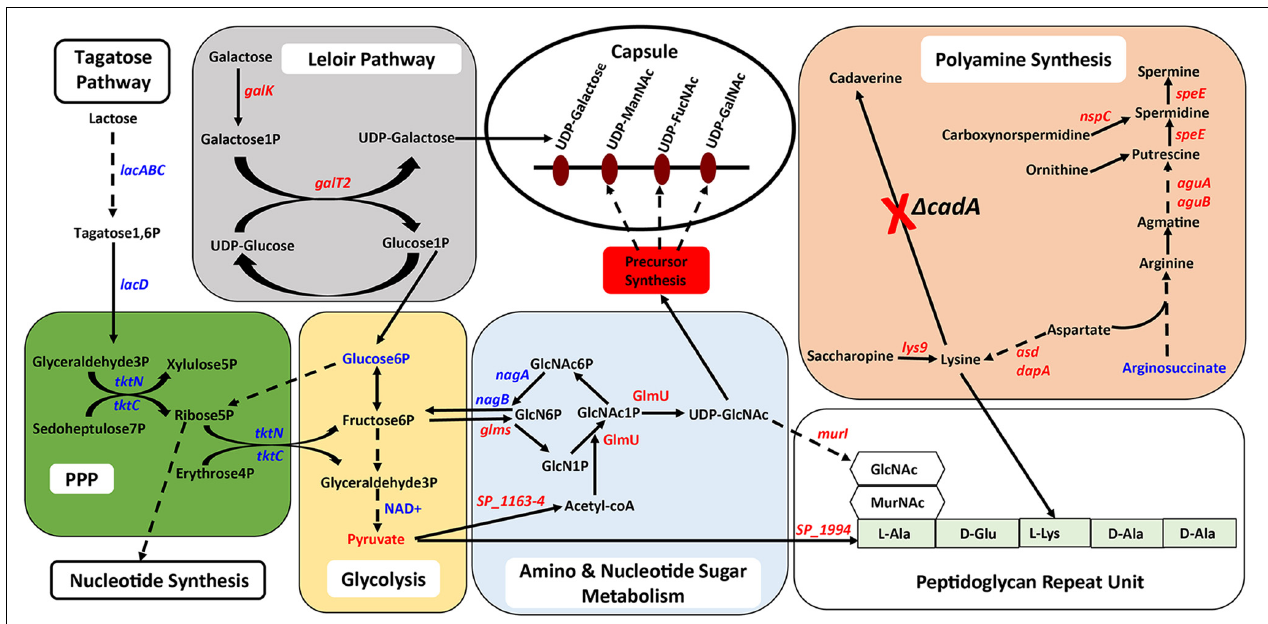
FIGURE 5 | Intersection between polyamine biosynthesis, carbohydrate metabolism, and the capsule in pneumococci. Interconnected metabolic pathways in a putative lysine decarboxylase synthesis deficient strain of S. pneumoniae TIGR4 ( (cid:49) cadA ) analyzed by RNA-Seq and metabolomics identified specific molecular mechanisms that could result in reduced intracellular levels of the constituents of the serotype four capsule and PG repeat structures. Enzymatic reactions are shown as black arrows and multi-step reactions are represented by a broken arrow. Changes in gene (italicized) and metabolite levels in (cid:49) cadA relative to the wild-type strain are shown (red represents decrease and blue represents increase). Deletion of cadA results in reduced expression of genes encoding biosynthesis pathways of polyamines such as putrescine, spermidine, and spermine and precursor amino acid lysine. Accumulation of arginosuccinate, an intermediate for the biosynthesis of arginine supports the notion of overall reduction in polyamine synthesis in (cid:49) cadA. Impaired polyamine synthesis renders pneumococci incapable of UDP-Glu to UDP-Gal interconversion, i.e., Leloir pathway (gray square), that could reduce the carbon flux through glycolysis (yellow rectangle). Despite increased carbon flux toward G3P, a glycolytic intermediate, through tagatose metabolism, changes in the levels of metabolites of glycolysis indicate reduced carbon flux. RNA-Seq data indicated that G3P is routed through the PPP (green square), and enhanced PPP activity will result in increased nucleotide synthesis. Changes in amino and nucleotide sugar metabolism (blue square) will result in reduced intracellular levels of UDP-GlcNAc, a precursor for three N -acetylated sugars in the serotype 4 capsule repeat unit (precursor nucleotide sugars shown in the open oval). Impaired Leloir pathway and UDP-GlcNAc synthesis will limit the availability of CPS precursors. Changes in metabolism in (cid:49) cadA , such as reduced glycolytic activity, altered UDP-GlcNAc metabolism and lysine synthesis impacts the assembly of the PG repeat unit (open rectangle) disaccharide and pentapeptide (light green rectangle). Polymerization of PG repeat units generates the cell wall which provides attachment for the